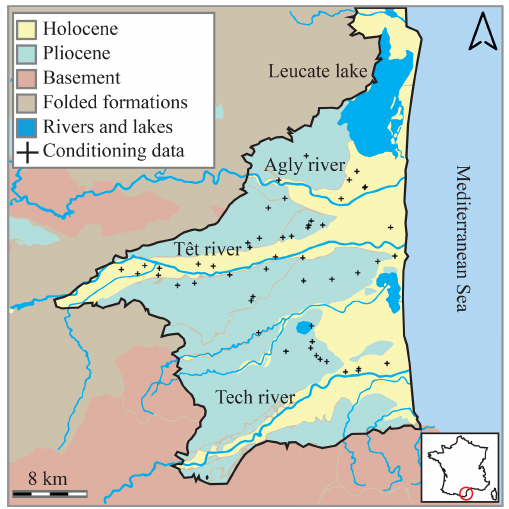
Figure 1. Simplified geological map of the Roussillon Plio- Quaternary